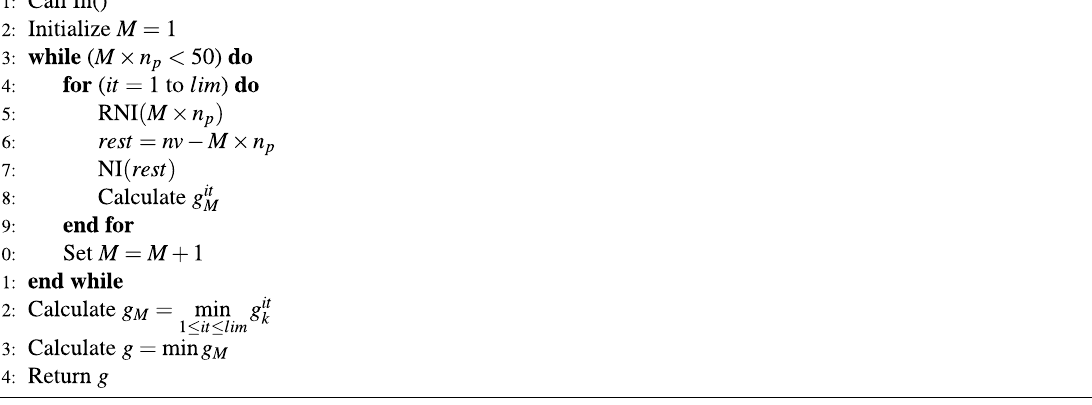
Table 5. M-vehicles with randomized-NI and NI algorithm (RN).